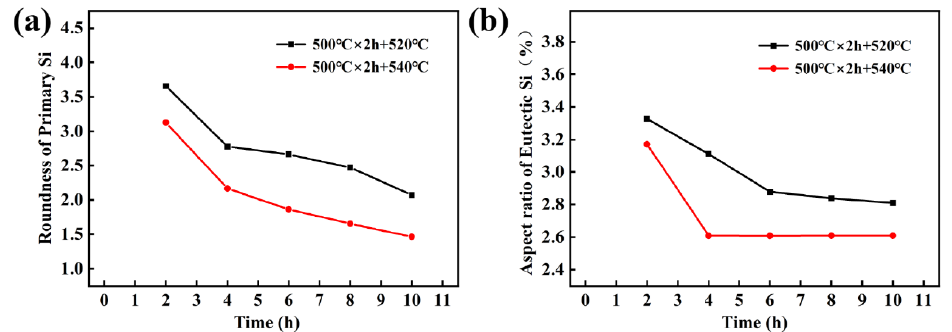
Figure 8. The statistics of Eutectic Si of Al-Si alloys with different SHT: ( a ) R a of Primary Si, ( b ) Aspect ratio of Eutectic Si.